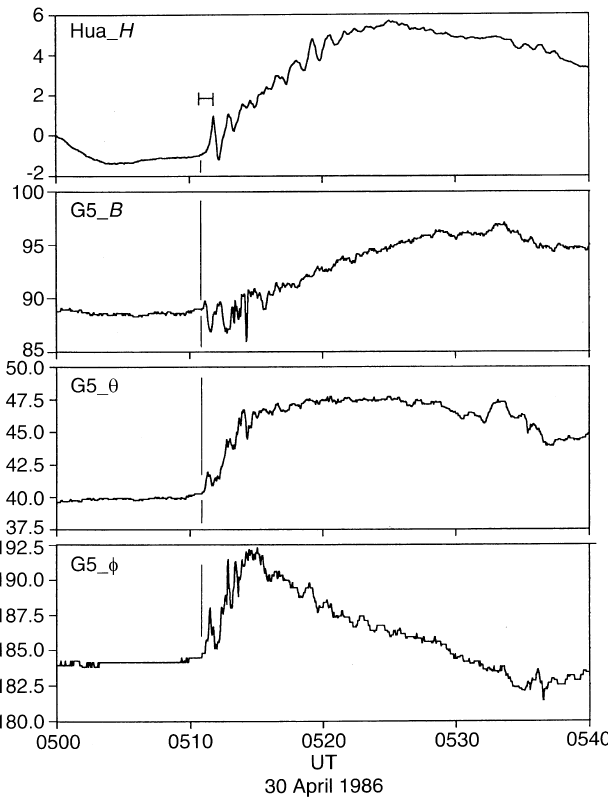
Fig 2. Enlarged plot (40-min interval) of the last Pi 2 event shown in Fig 1. Particle data are not included. The original plot of the H component (positive northward) is shown instead of the power spectra. The vertical bar indicates the onset of the field line changes at the geosynchronous altitudes, which occurred in the 1-min interval ( horizontal bar ) of the Pi 2 onset